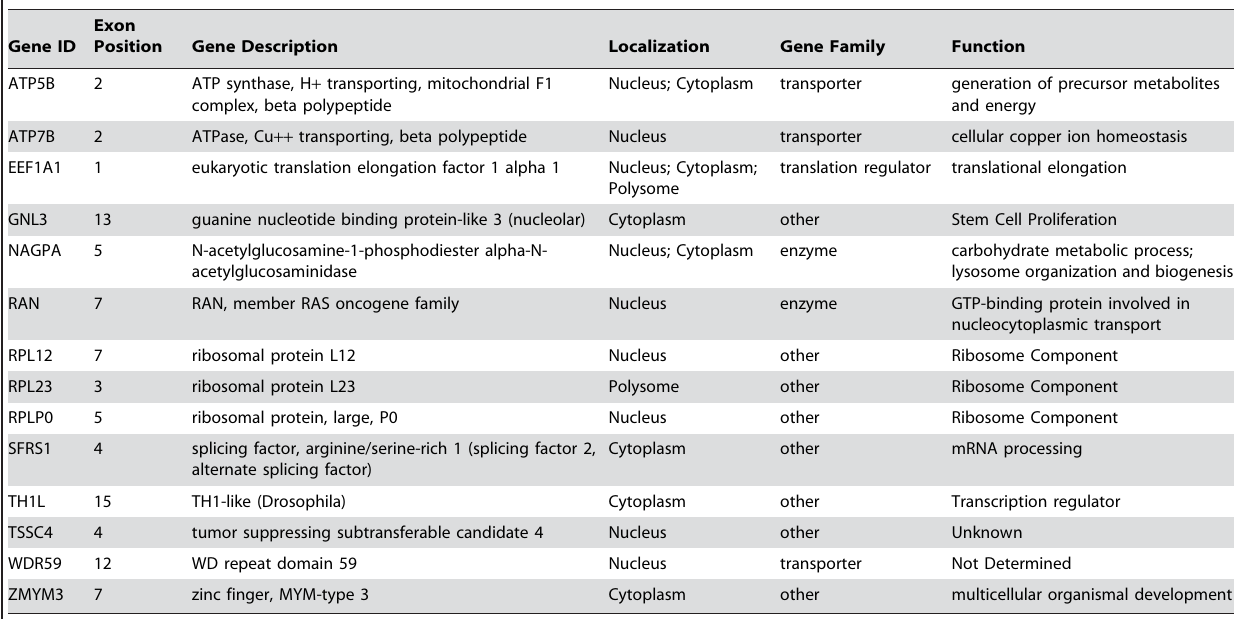
Table 4. Annotated as described in Table 1.